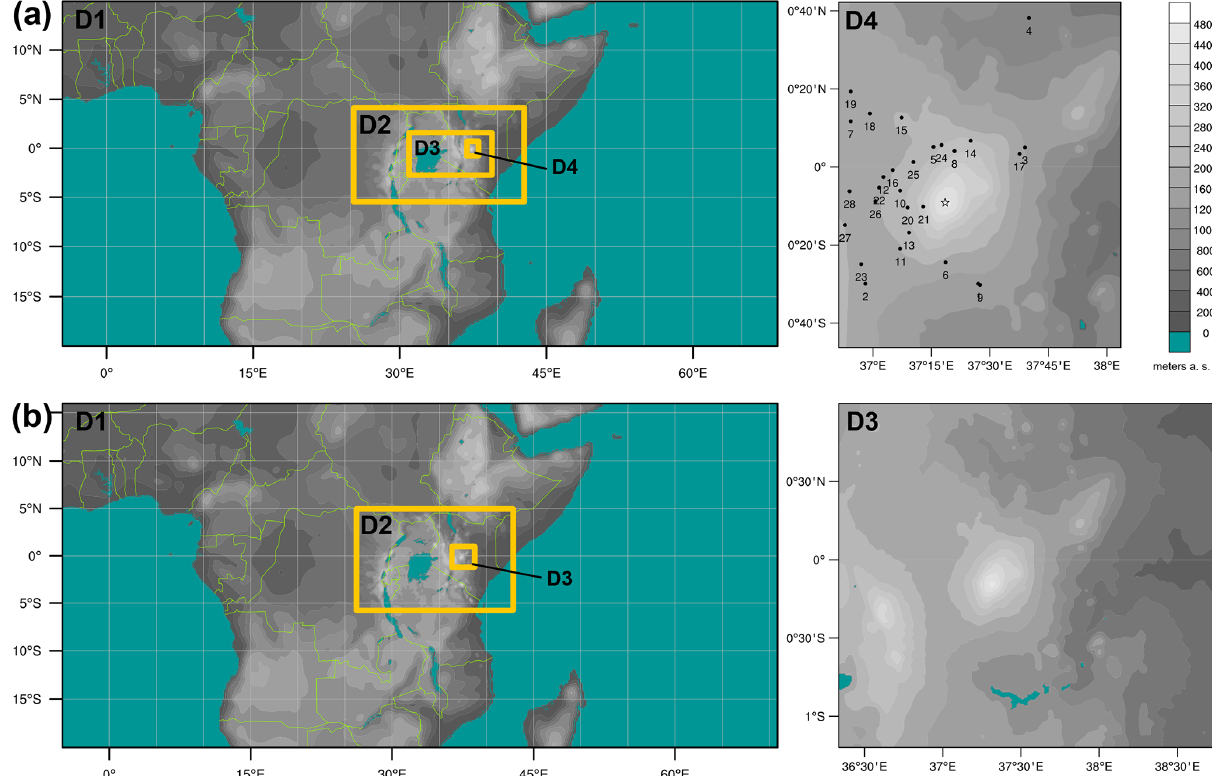
Figure 1. The two different nesting settings for the sensitivity experiments are depicted. The four domains (D1 = 27km, D2 = 9km, D3 = 3km, D4 = 1km) of the nesting ratio 1 : 3 are shown in row (a) , with the topography of the innermost nest D4 in the right panel. The three domains (D1 = 25km, D2 = 5km, D3 = 1km) of the nesting ratio 1 : 5 are shown in row (b) , with the topography of the innermost nest D3 in the right panel. The grey shading indicates elevation in metres above sea level using the WRF topography Global Multi-resolution Terrain Elevation Data (GMTED2010) provided by USGS. The location of the weather station data is provided in D4, and a more detailed description of each station is available in Table 2. The black star in D4 indicates the summit of Mount Kenya. Note that at least 30 grid points from the edge of the boundaries of an inner domain to the limit of an outer domain are used to avoid effects from the relaxation zone (spanning five grid points) between two nests (Rummukainen,